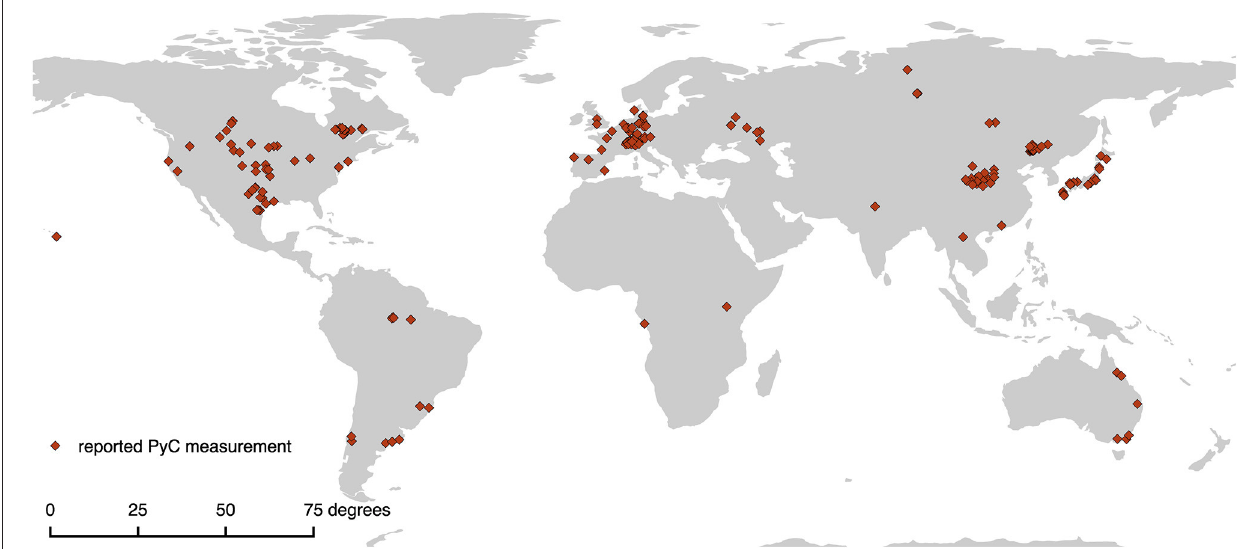
FIGURE 3 | Spatial distribution of the PyC values which were published and taken into account in our